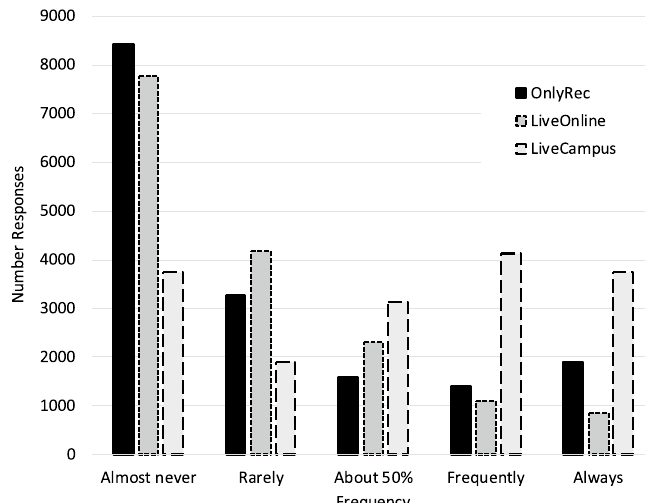
Fig. 1 Number of students versus frequency of attendance on campus ( LiveCampus ), attendance online ( LiveOnline ), and only watching the recordings ( RecOnly )